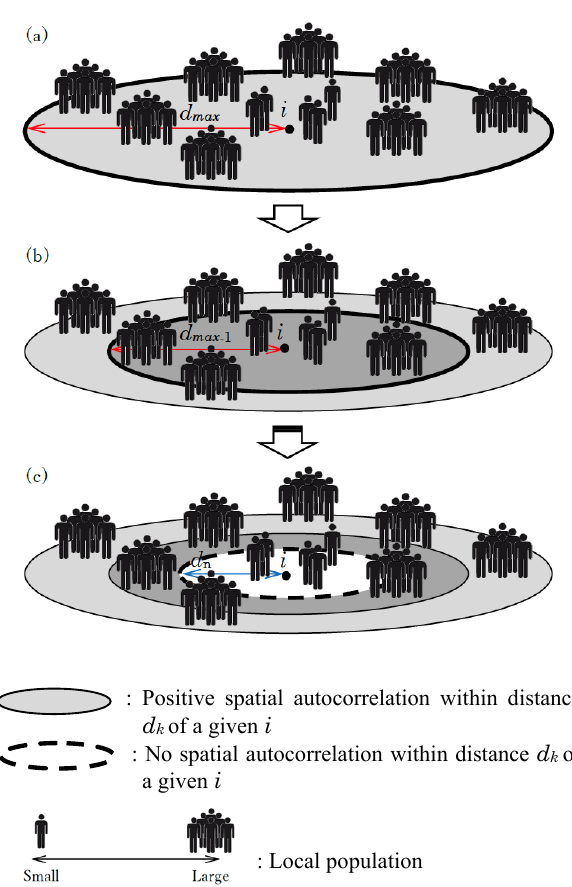
Figure 4 . Conceptual diagram with respect to the detection of the spatial features of local populations.